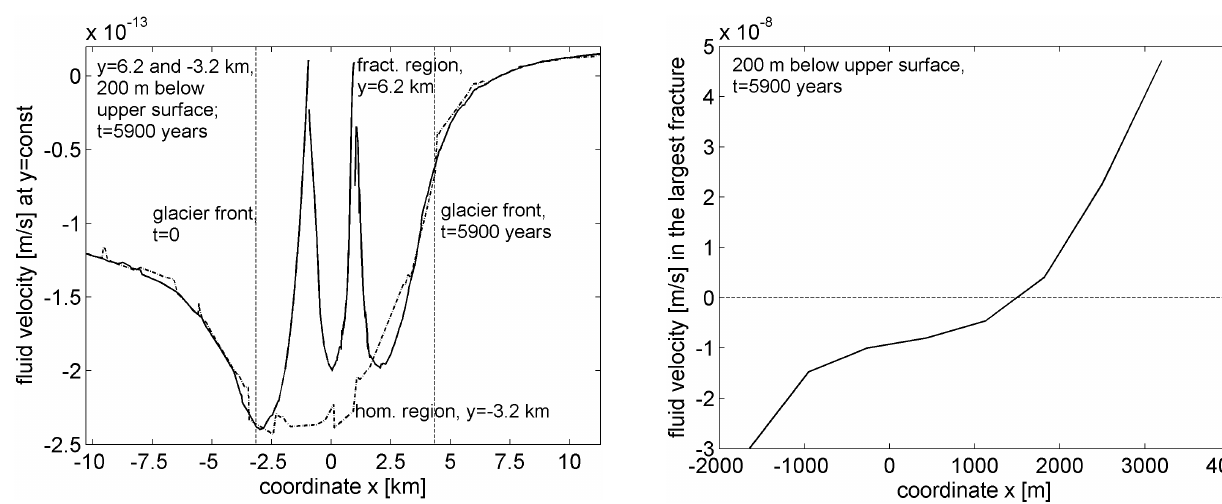
Figure 11. Variation of the vertical fluid velocity [ms − 1 ] in the largest fracture zone, at a depth of 200m and at time 5900 years. Velocity is approximately uniform across the fracture’s thickness.